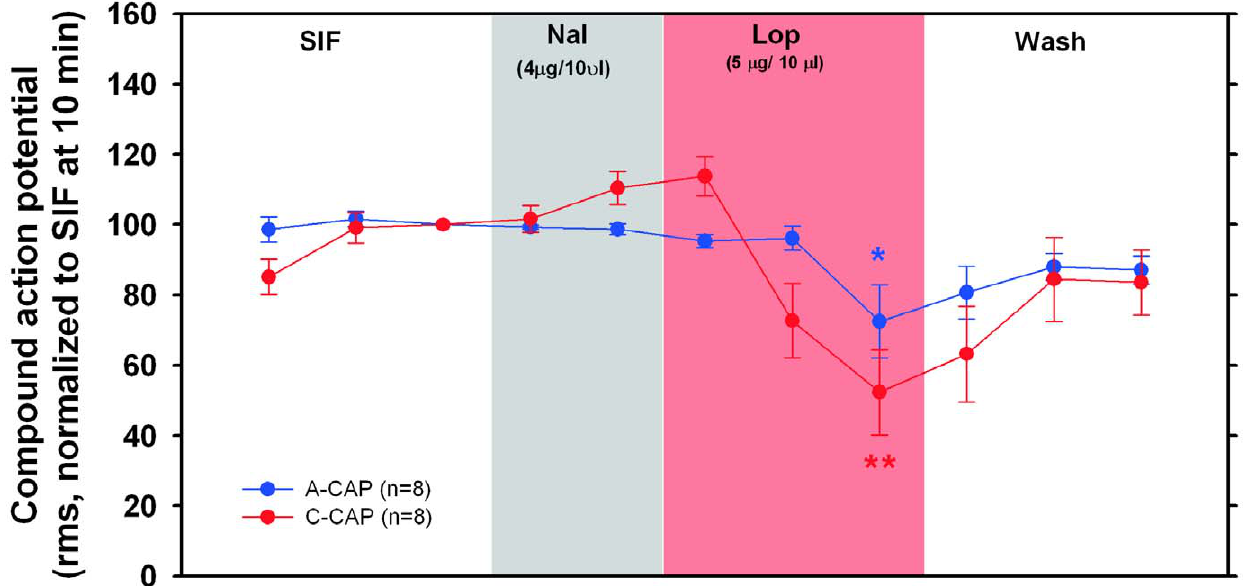
Figure 8. Naloxone does not prevent the conduction blockade effects of loperamide. The nerve was preincubated with naloxone (4 m g/ 10 m l) for 5 minutes followd by incubation with loperamide (5 m g/10 m l for 10 min). Preincubation with naloxone did not prevent loperamide induced changes of A- and C- CAPs (p , 0.001, repeated measures ANOVA). Incubation with loperamide significantly reduced A-CAP and C- CAP compared to 5 min SIF incubation (**p , 0.01, *p , 0.05, paired t-test,